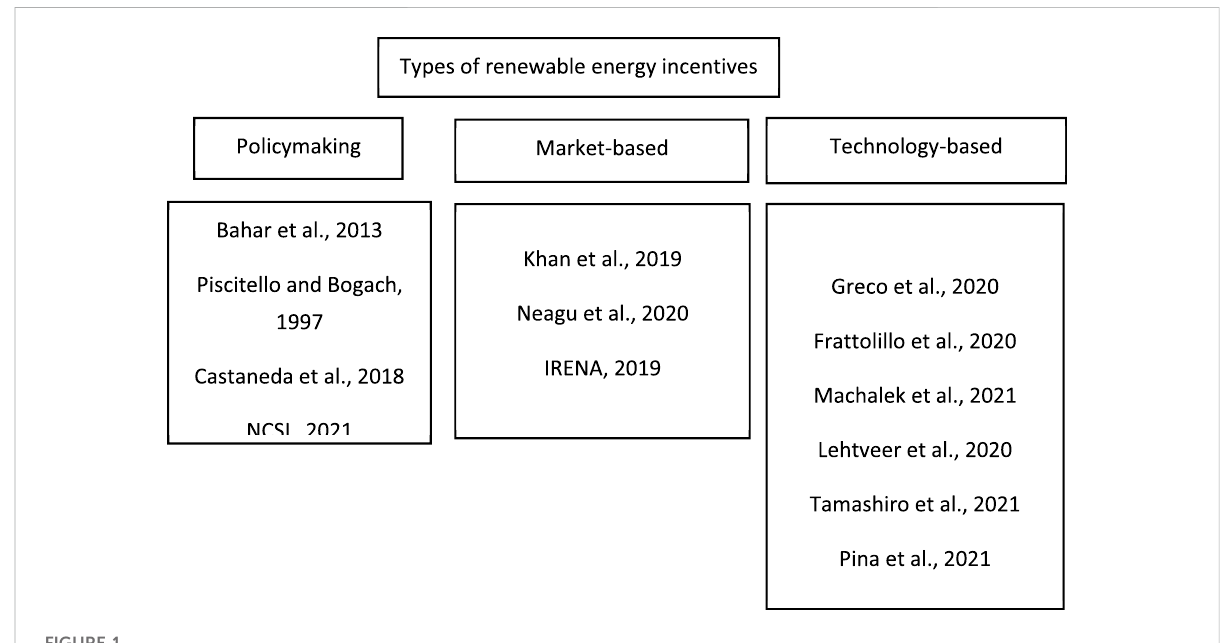
FIGURE 1 Types of renewable energy incentives covered in the literature. Source: prepared by the